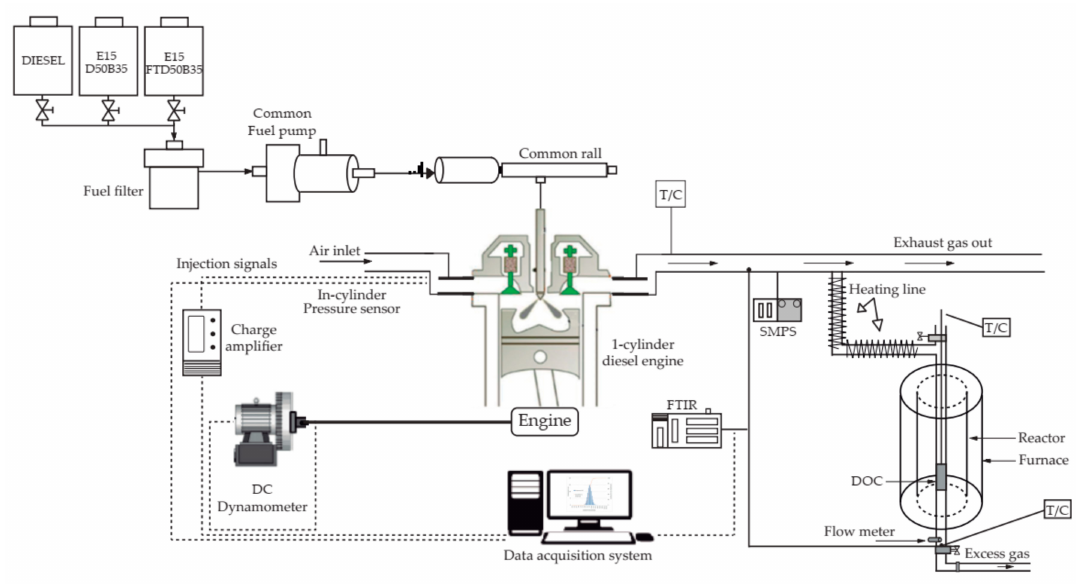
Figure 1. Schematic of the experimental